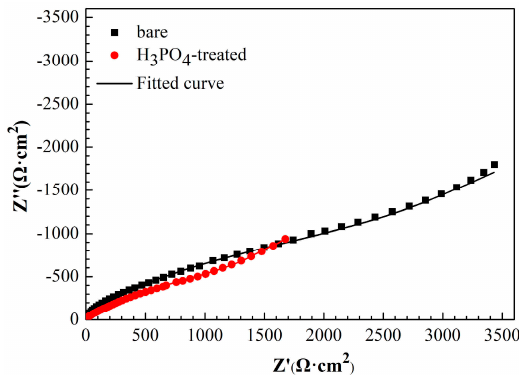
Figure 7. Nyquist plots of copper electrode with or without H 3 PO 4 solution treatment.